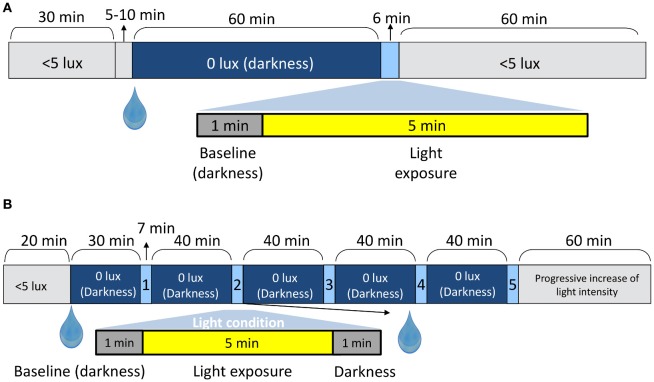
In-laboratory protocol for Study A (A) and Study B (B). The drop symbol shows the time when the pupil dilator was administered. The up arrows point to the duration (mins) of the shorter periods.